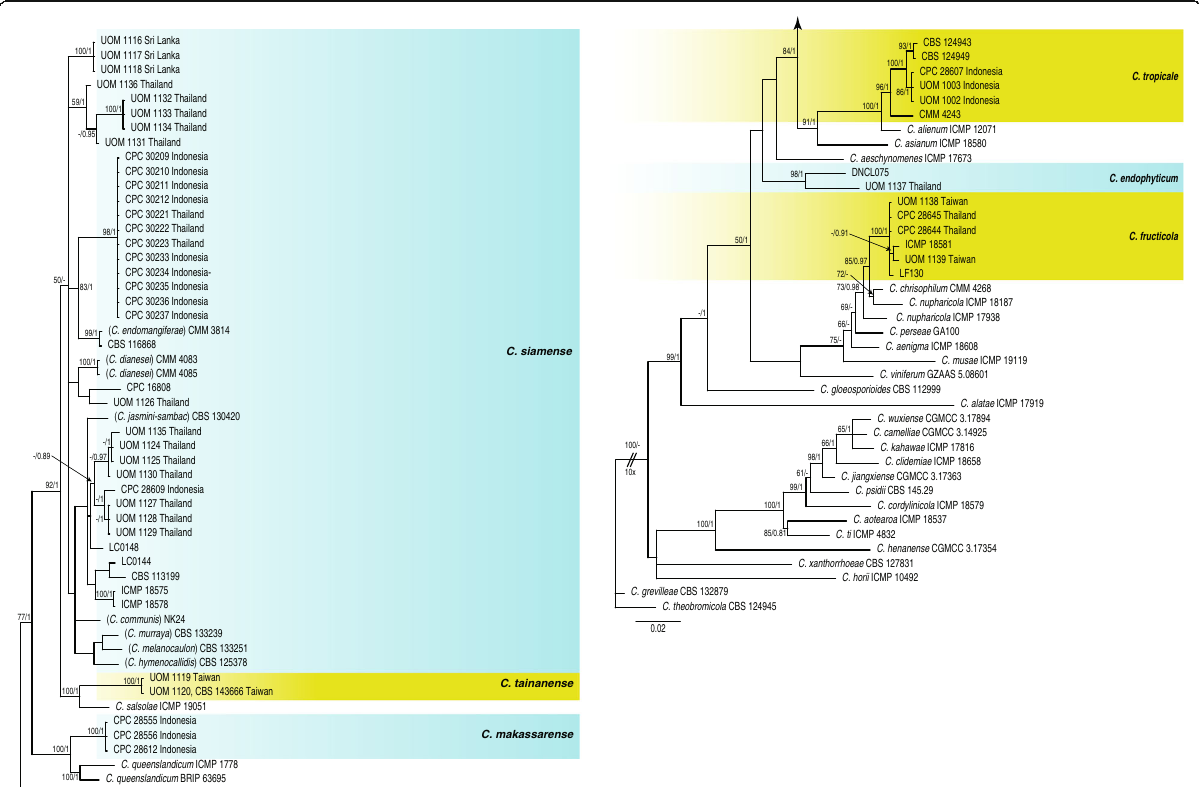
Fig. 3 Phylogenetic analysis of Colletotrichum isolates in the gloeosporioides complex based on a 50% majority rule consensus tree derived from Bayesian analysis of the ApMat and gs regions. The parsimony bootstrap support values (MP > 49%) and Bayesian posterior probabilities (PP > 0.90) are displayed at the nodes (MP/PP). The tree was rooted to C. theobromicola (CBS 124945). The bar indicates 0.02 expected changes per site. Coloured blocks are used to indicate clades containing isolates from